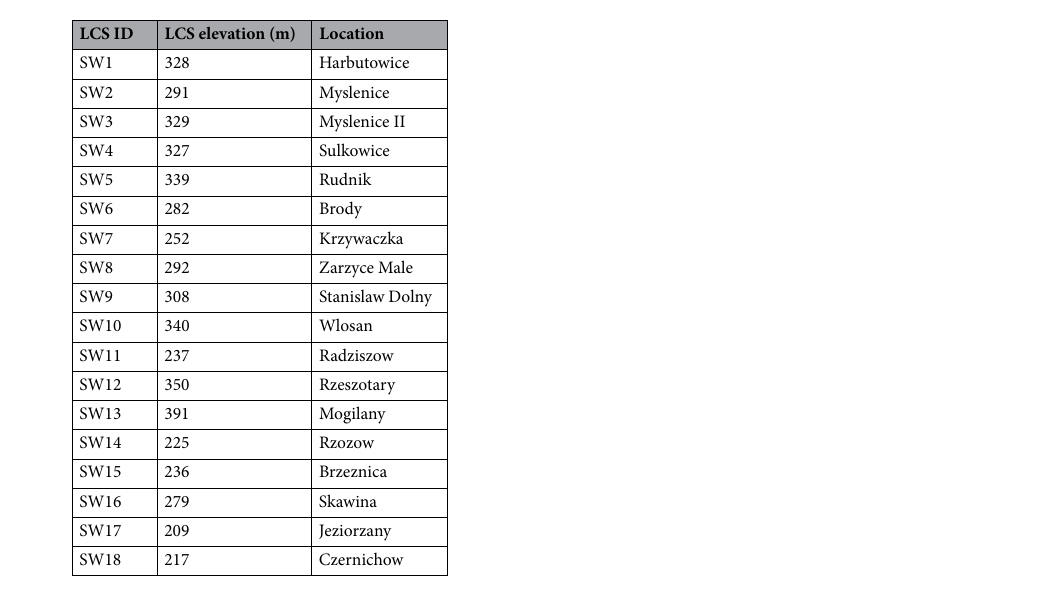
Table 3. Sensor location and elevation in the south-west section (outside the urban areas of Krakow).